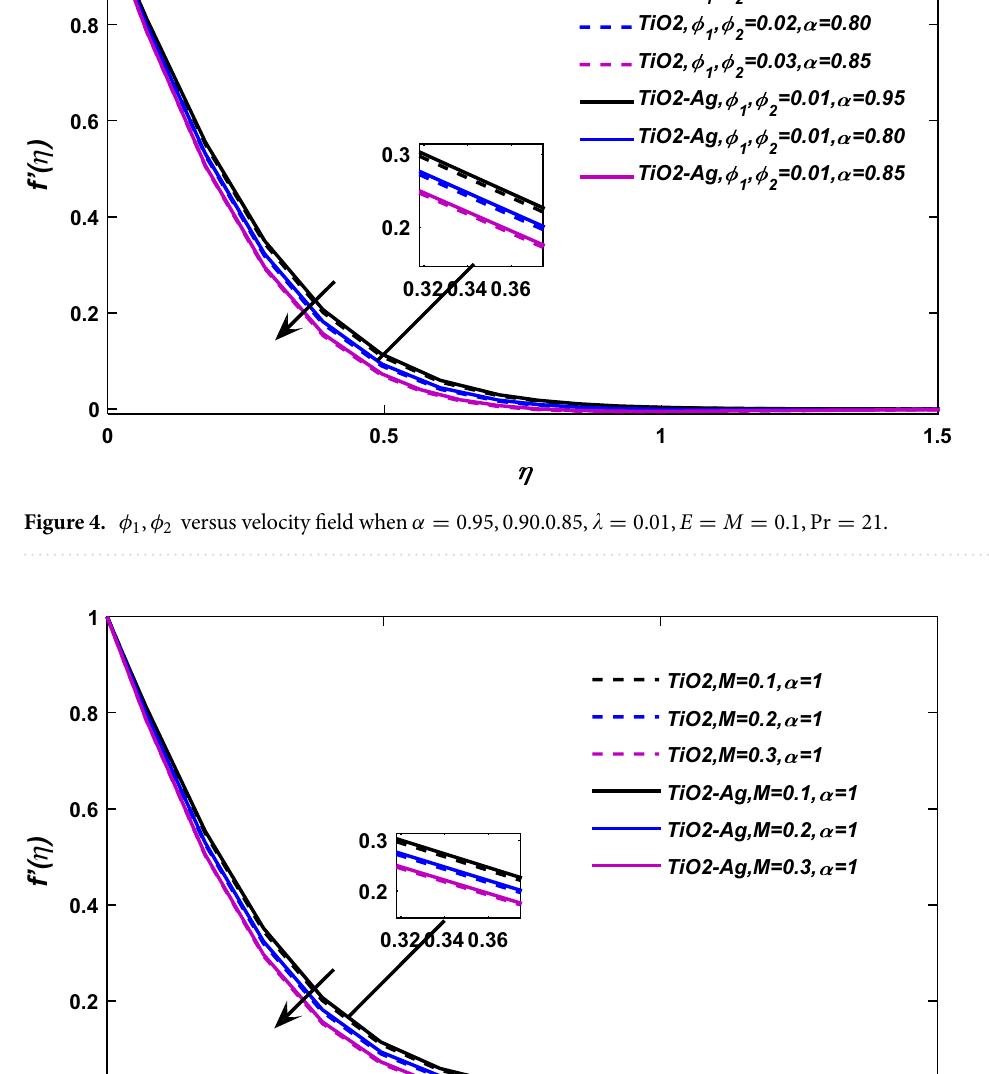
The consequences of magnetic force coefficient M on temperature profile �(η) is elaborated through Figs. 11 and 12 respectively. The opposing force which is generated due to the magnetic effect causes friction between the flow field and free ions. That friction force produces some amount of heat, which when added to the fluid, raises the average temperature of the fluid. Figures 13 and 14 manifest the nature of thermal energy �(η) transition versus electric effect parameter E . The temperature profile enhances with the increment of electric force factor E . because the rising trend in electric effect boosts the kinetic energy between fluid molecules, which encourages fluid temperature to improve. The Eckert number upshot on the energy profile has been displayed via Figs. 15 and 16. In which, Fig. 15 revealed the classical case at α = 1, and Fig. 16 report the non-integer case, respectively. The Eckert number describes the rela- tionship between enthalpy and kinetic energy in a flow. It involves the activities performed against viscous fluid pressures to convert kinetic energy into internal energy. A rise in the Eckert number indicates that the kinetic energy of the fluid is high, resulting in increased fluid vibration and increased fluid-molecule collisions. Increased molecule collisions increase heat dissipation in the boundary layer field, increasing the temperature profile.